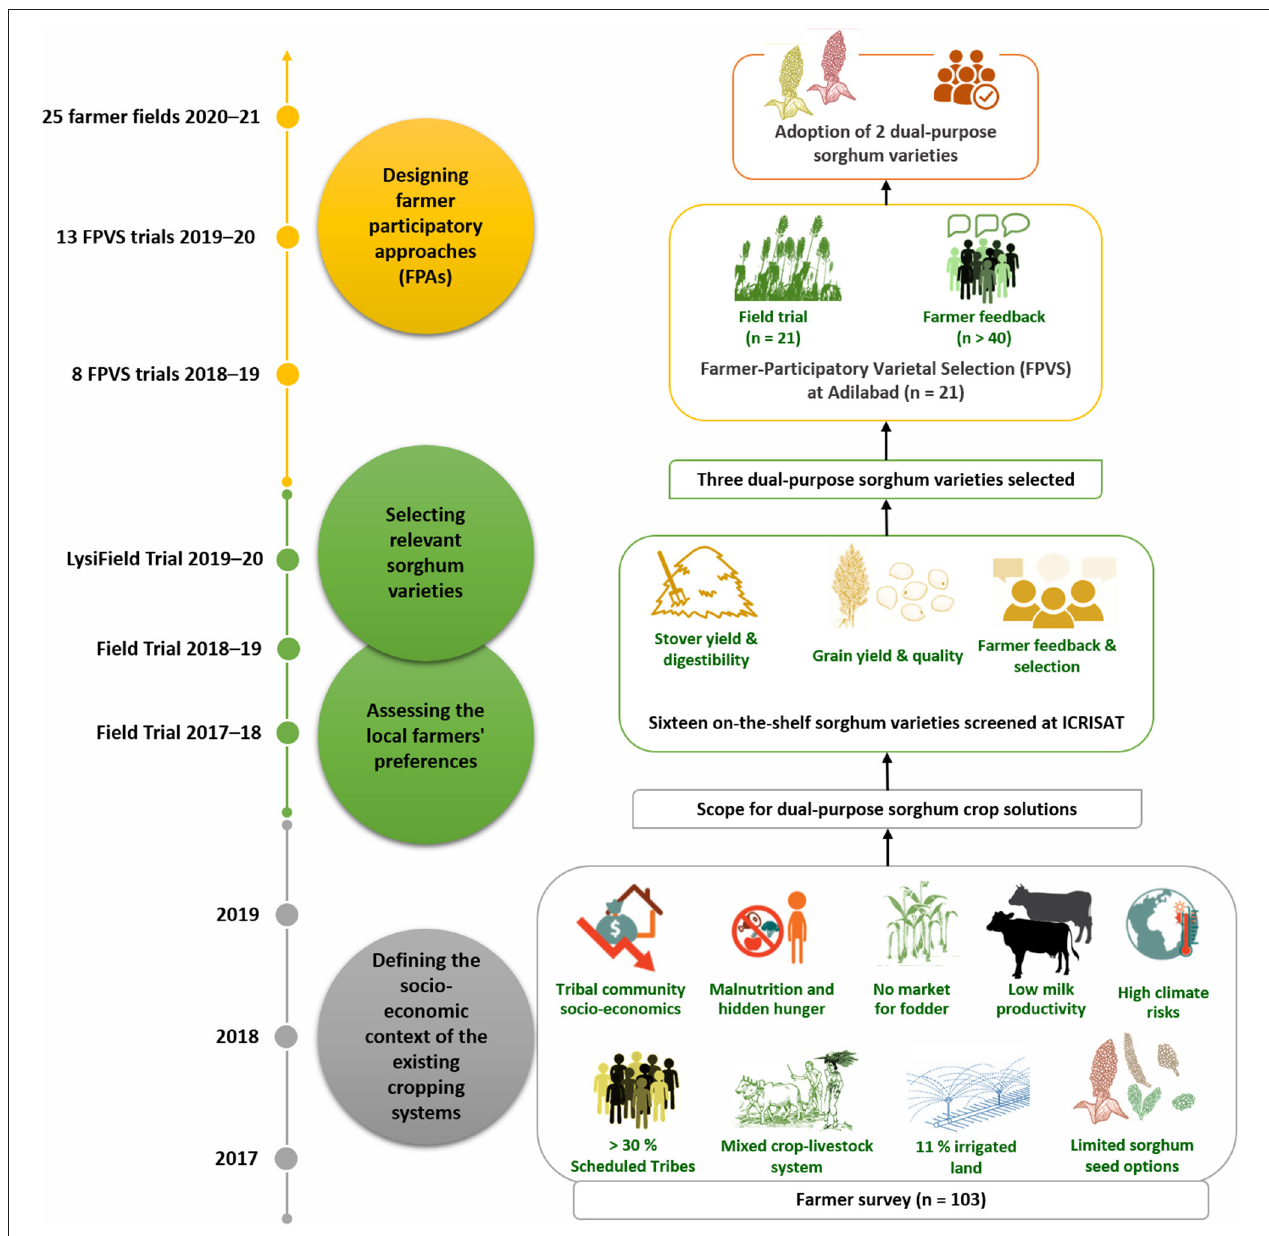
FIGURE 2 | Schematic diagram representing the project objectives, activities, observations and progress across the years.